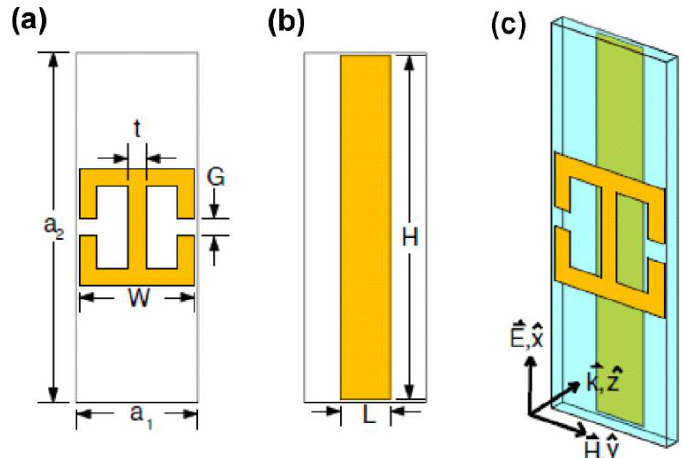
Figure 2. Electric resonator ( a ) and cut wire ( b ). Dimension notations are listed in ( a ) and ( b ). The unit cell is shown in ( c ) with axes indicating the propagation direction [16]. (Reprinted with permission from [16]. Copyright 2008 American Physical